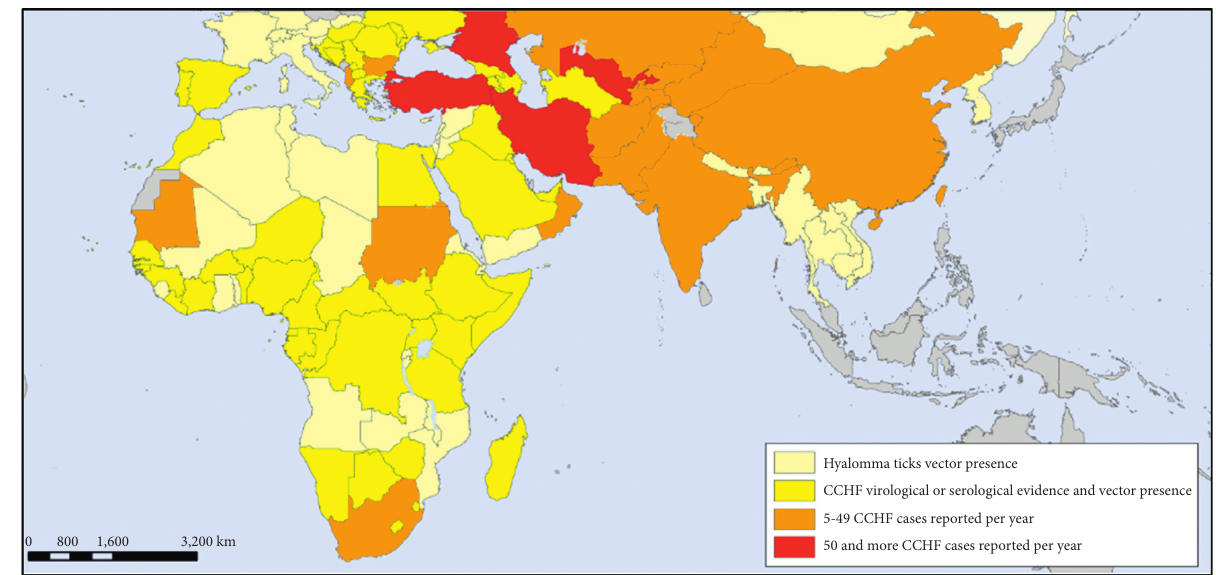
Figure 1: World-wide map of CCHF distribution